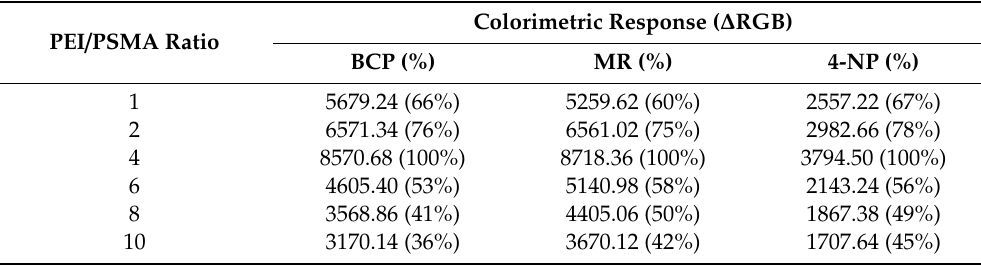
Table 1. ∆ RGB (%) values of the BCP, MR, and 4-NP sensors with various PEI / PSMA ratios (formaldehyde: 20